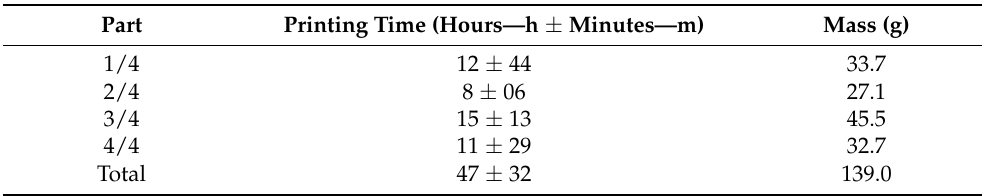
Table 5. Time results, in hours, of 3D printing the proposed immobilization mask in 4 parts and respective masses, in grams.